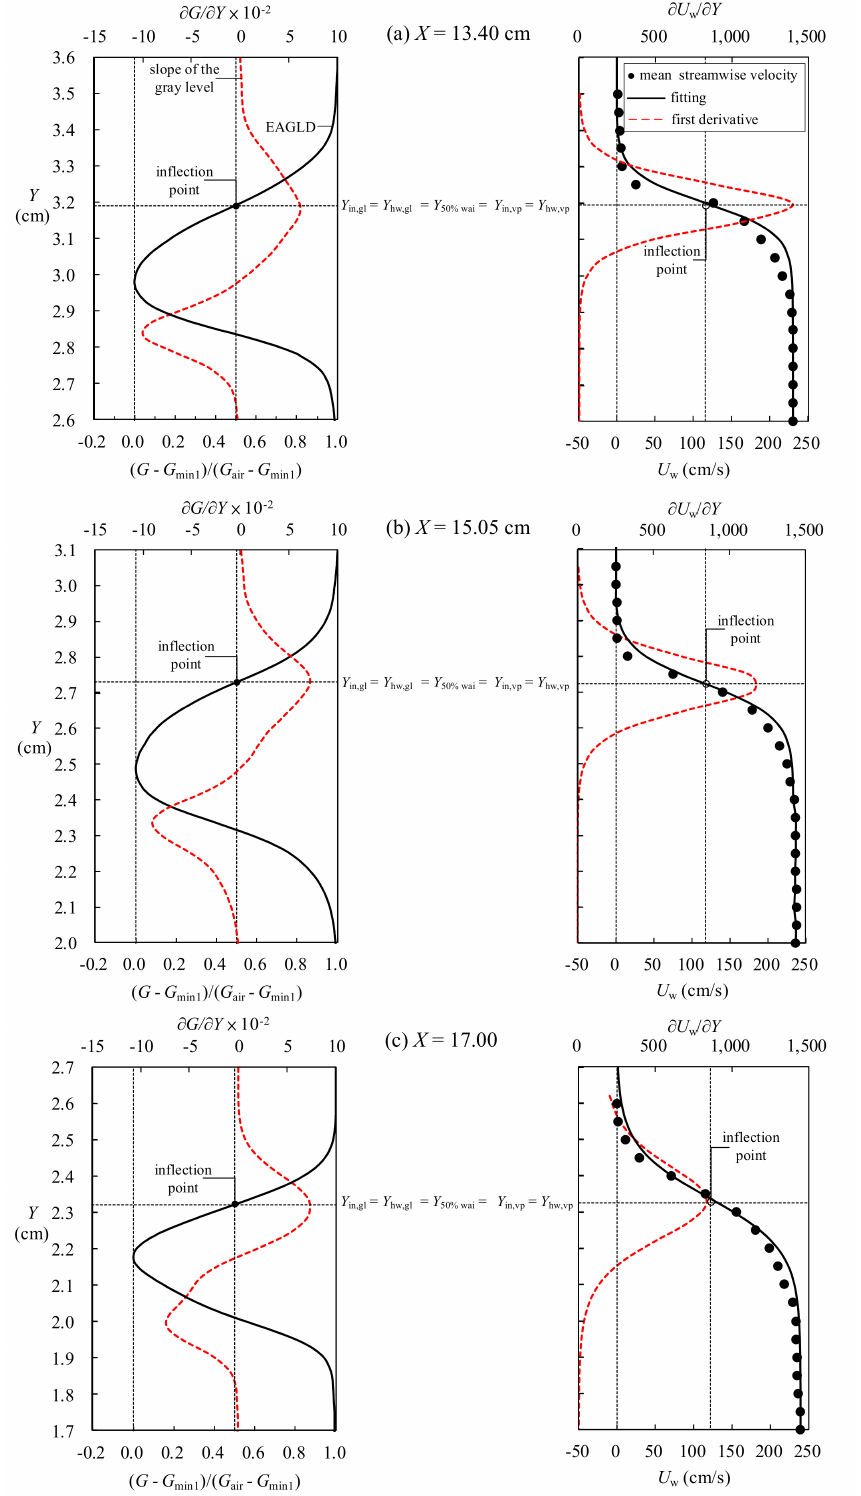
Figure 21. Plots of both G ( Y ) and ∂ G ( Y ) / ∂ Y shown in the left panel as well as both U w ( Y ) and ∂ U w ( Y ) / ∂ Y in the right panel for ( a ) X = 13.40 cm; ( b ) X = 15.05 cm; ( c ) X = 17.00